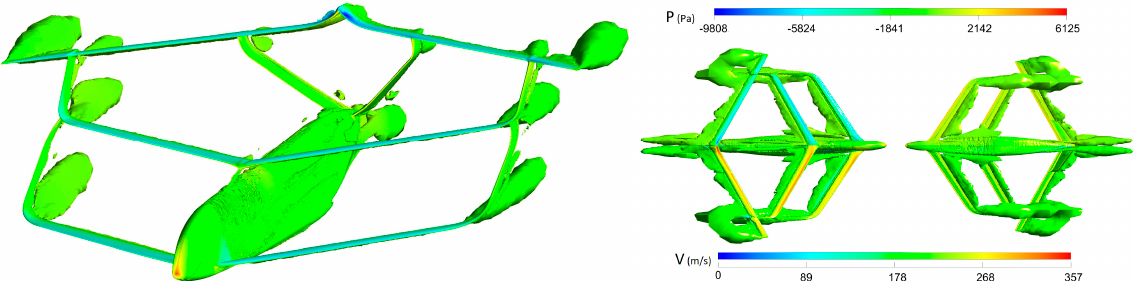
Figure 19. BWA/SL aircraft in cruise flight condition S3 (M = 0.7 at 43,000 ft) with an angle-of-attack α = 0°. ( Left ): Vorticity field (swirling magnitude) depicted as Q-criterion iso-surfaces. ( Right ): Same result , as seen from the suction ( left ) and pressure ( right ) sides, along with the planform distribution in velocity (bottom half) and static pressure (top half).